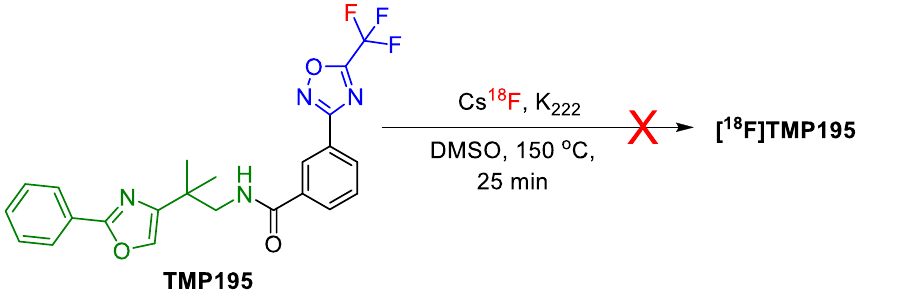
Figure 6. Investigating the 19 F- to [ 18 F] isotopic